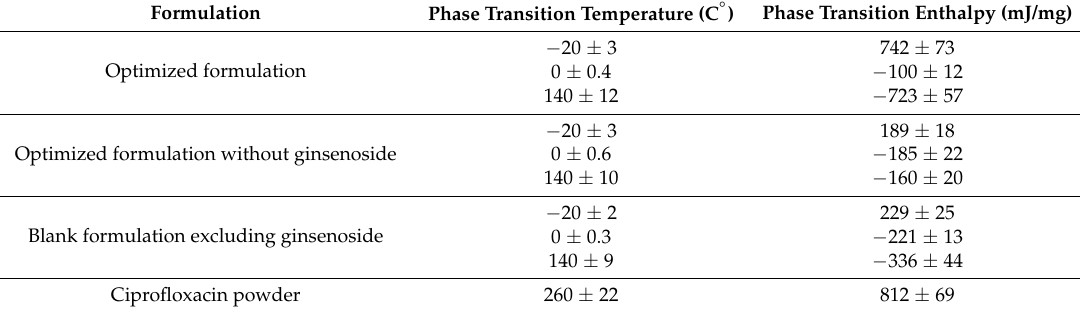
Table 3. Transition temperature and enthalpy of optimized and blank formulations in heating program (mean ± SD, n = 3).